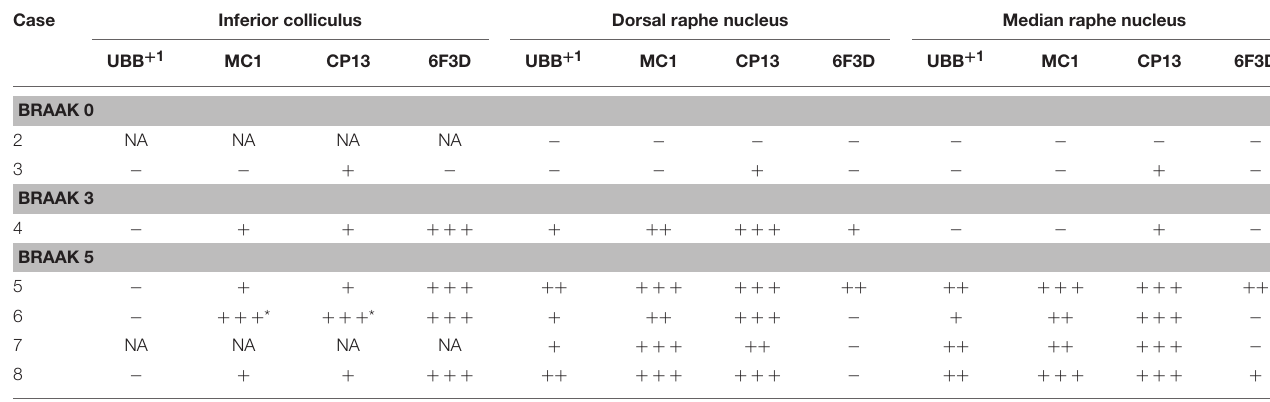
TABLE 5 | Immunoreactivity for UBB + 1 , pre-tangle material (MC1), tangles (CP13), and plaques (6F3D) in vibratome sections of the IC and the raphe nuclei of controls (Braak stage 0), intermediate phase (Braak stage 3) and AD patients (Braak stage 5). Case Inferior colliculus Dorsal raphe nucleus UBB +